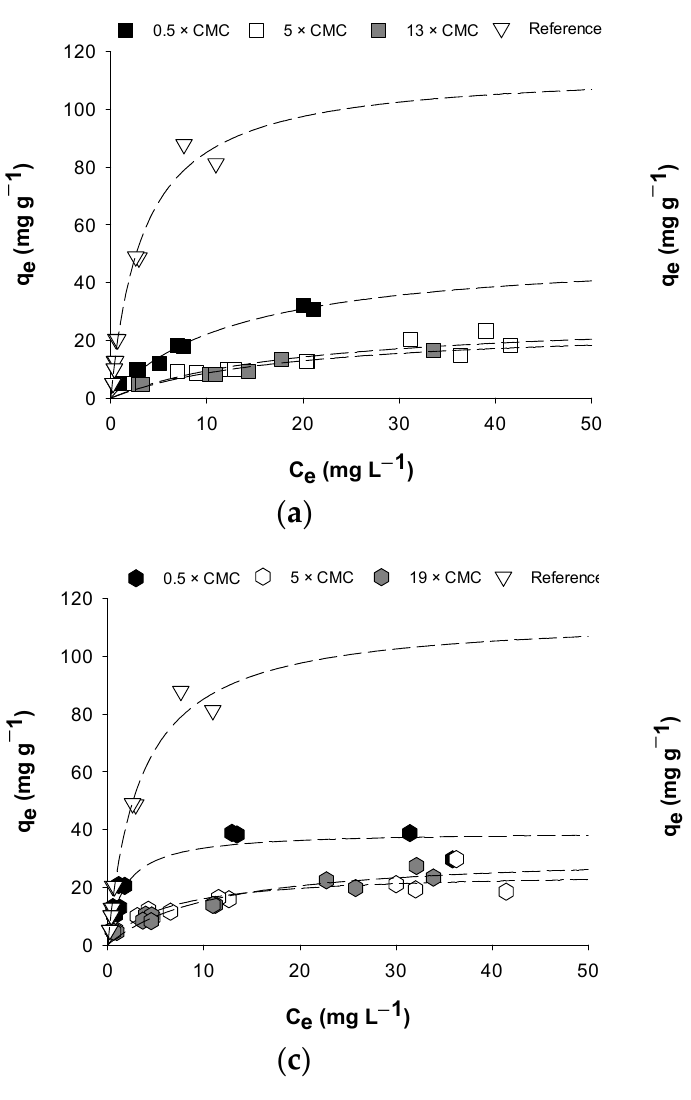
Reference Figure 4. Cont